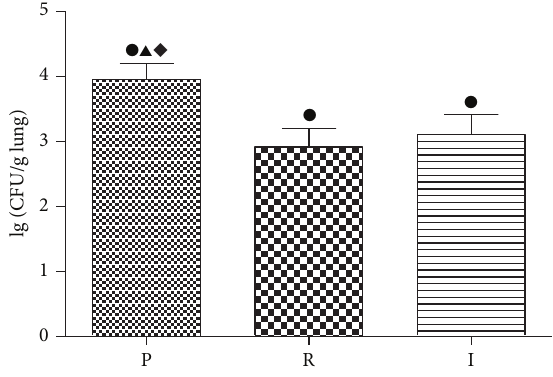
Figure 1: Logarithm of colony-forming units of the three experi- mental groups. Logarithm of colony-forming units of PAO1 group (P), Δ lasR Δ rhlR group (R), and Δ lasI Δ rhlI group (I) in lung tissues after the rats were sacrificed at the seventh day. e : compared with control group, 𝑝 < 0.05 . 󳵳 : statistically significant differences between PAO1 and Δ lasR Δ rhlR group, 𝑝 < 0.05 . X : statistically significant differences between PAO1 and Δ lasI Δ rhlI group, 𝑝 < 0.05